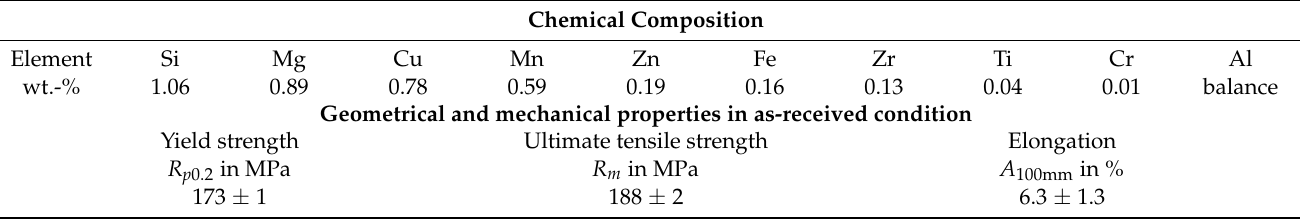
Table 1. Chemical composition and initial properties of the used commercial 6056 (AlSi1MgCuMn) aluminum wire as